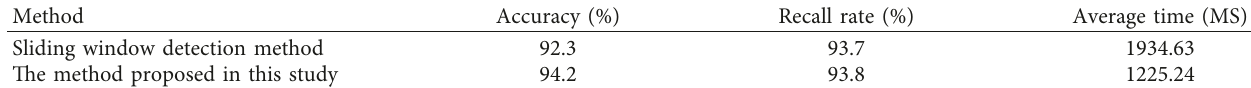
Table 13: Statistics of test results of large remote sensing